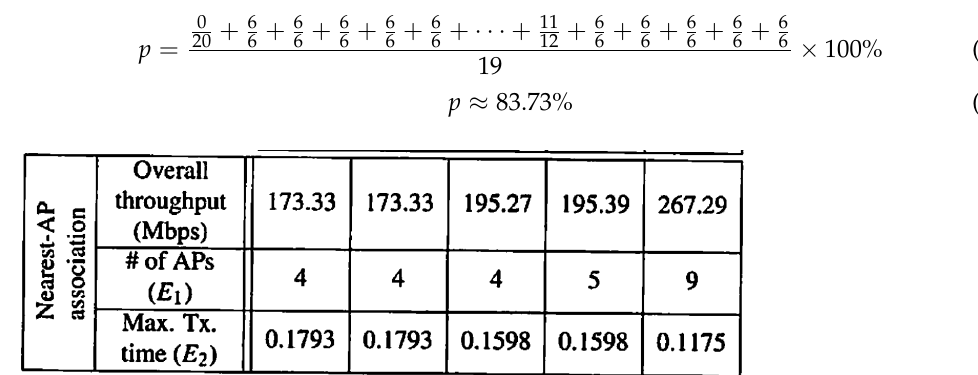
Figure 22. Printed table of scanned table image 4.